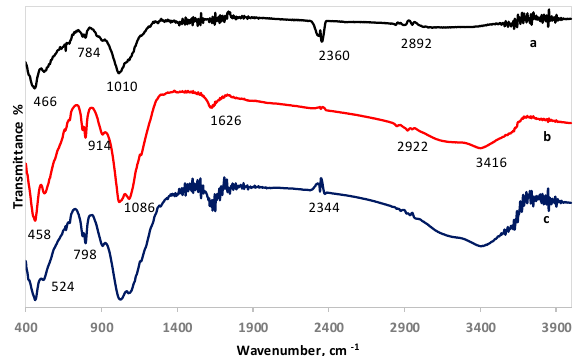
Figure 3. FTIR spectra of ( a ) LAI, ( b ) residue after column leaching with 1.5 M H 2 SO 4 , and ( c ) residue after column leaching with 1.5 M H 2 SO 4 with 20 g/L Na 2 SO 3 .